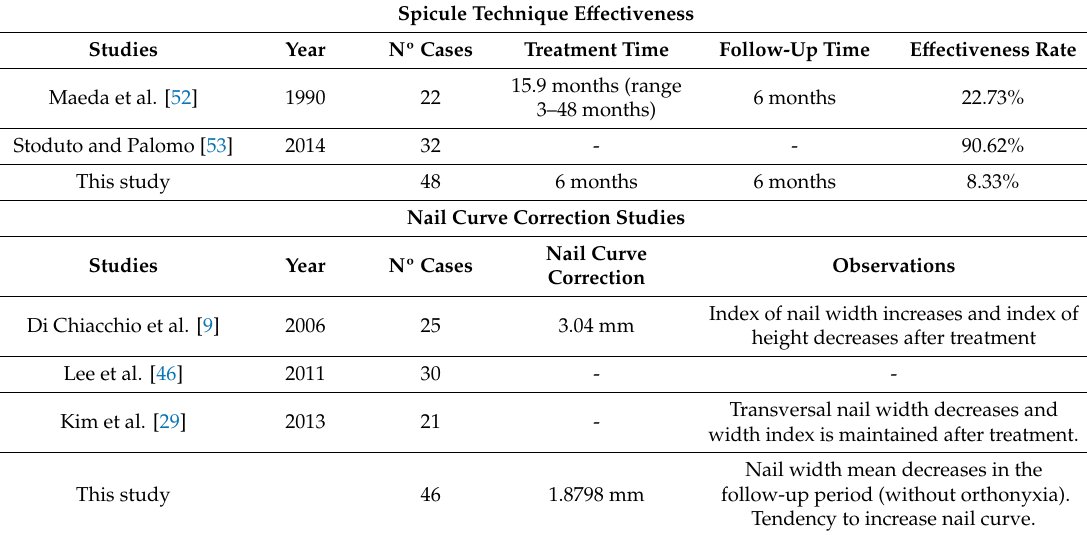
Table 4. Studies of spicule technique e ff ectiveness and the nail curve correction with nail reeducation